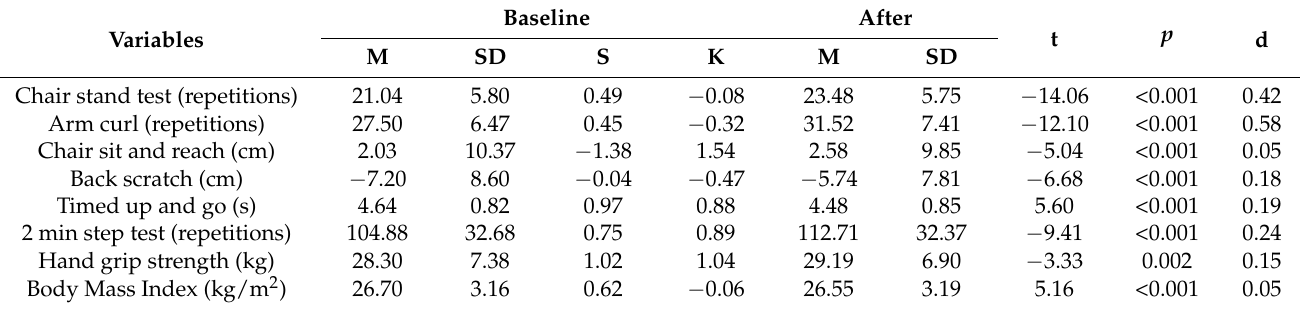
Table 1. Results of study endpoints of the total sample ( n = 48) at baseline and after exercise